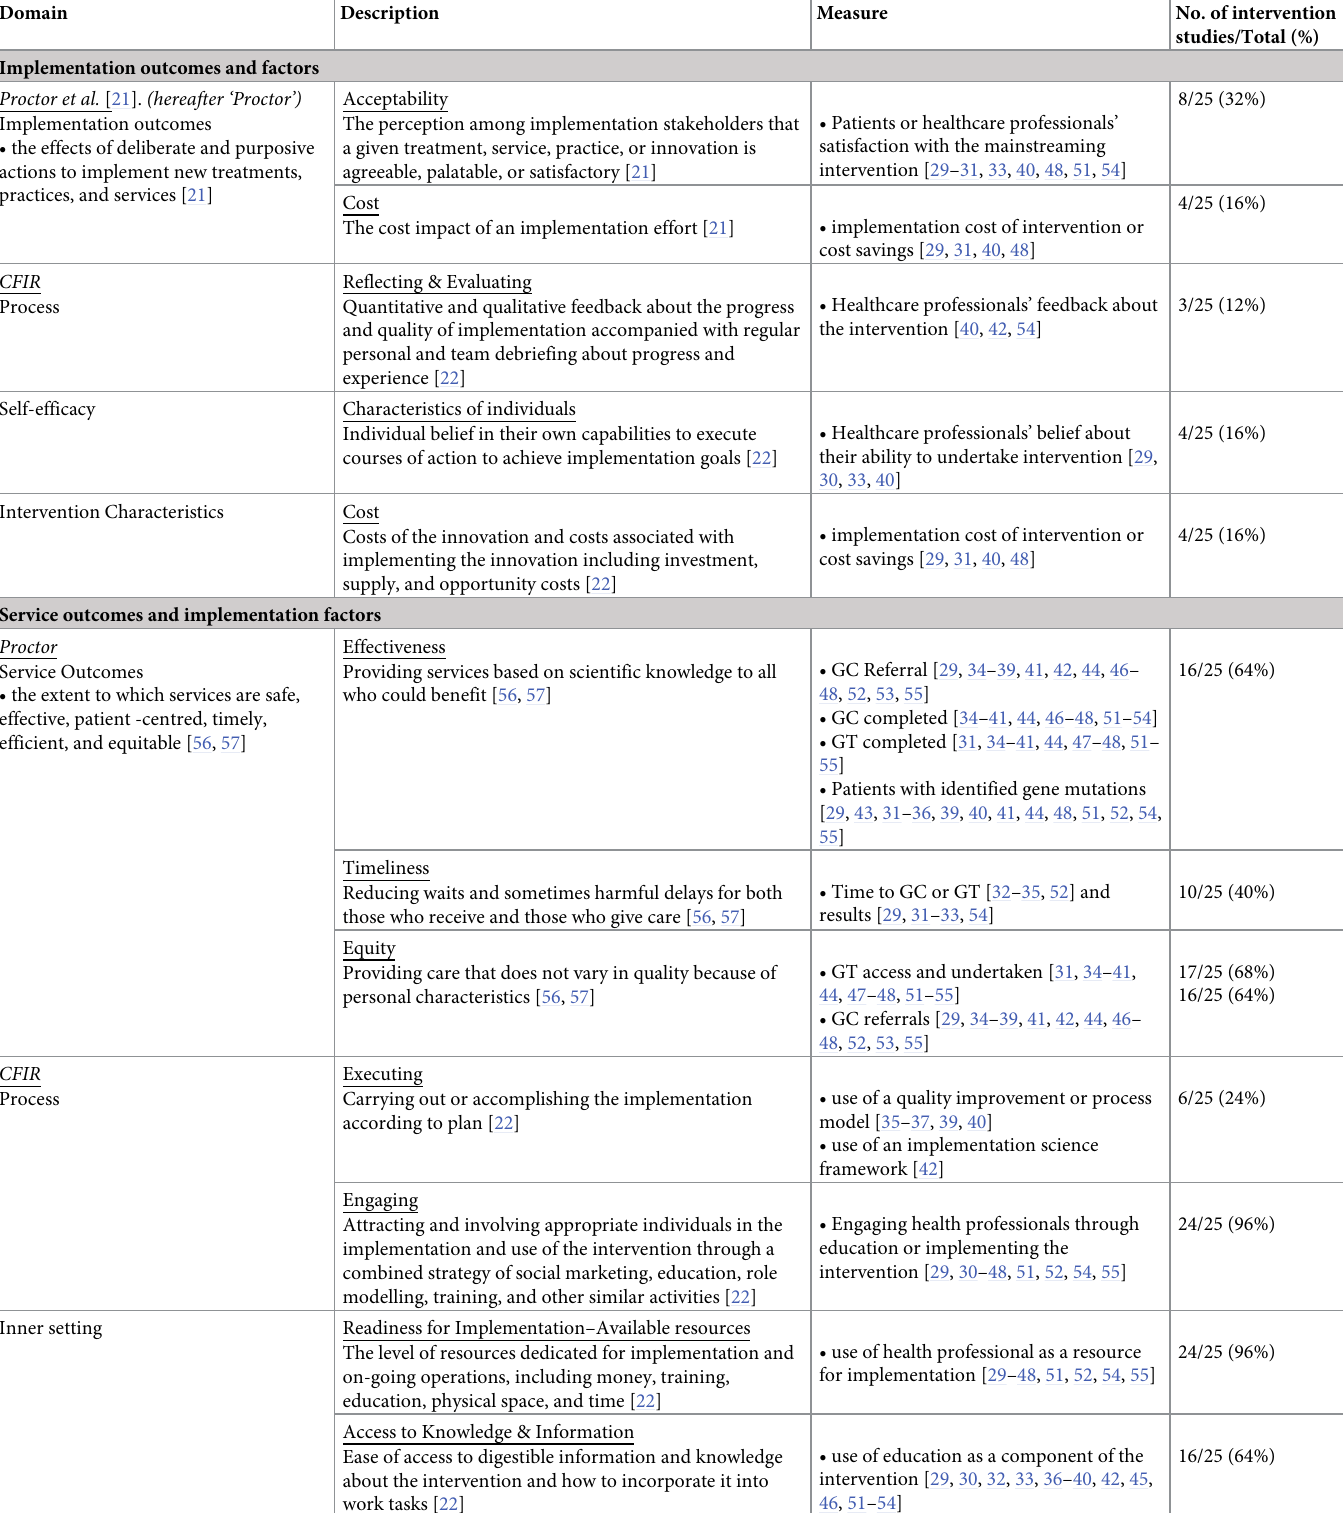
Table 3. Proctor et al.’s implementation outcome framework [21] and CFIR [22] applied to outcomes of included studies.